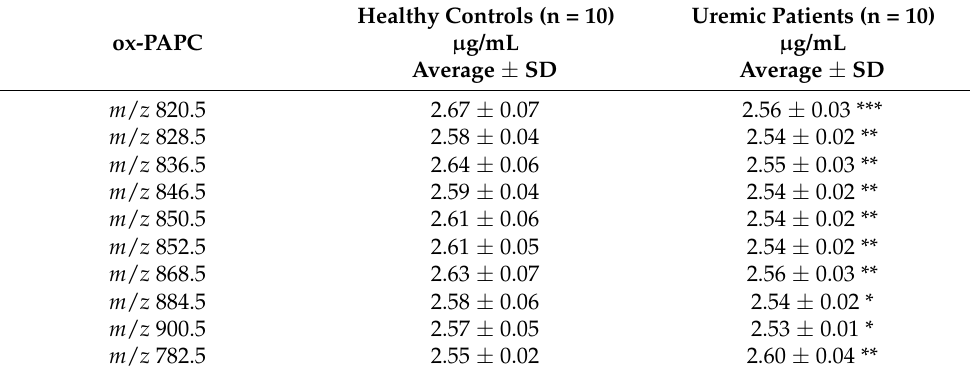
Table 5. Long-chain ox-PAPC product concentrations in HDL of healthy controls and uremic patients.